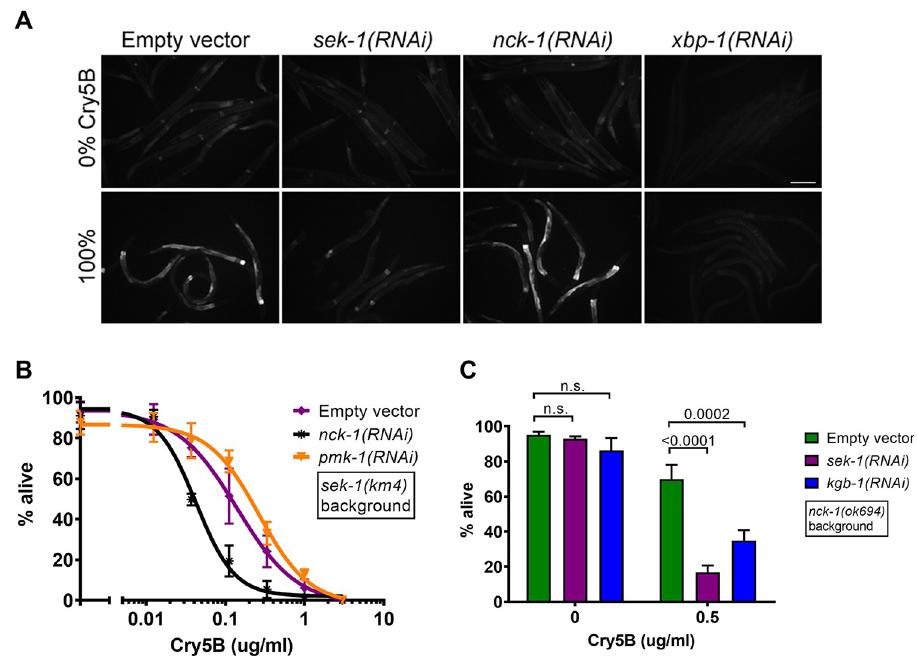
Fig 2. nck-1 works independently of MAPK signaling. (A) hsp-4 :: gfp C . elegans were grown to the L4 stage on the indicated RNAi bacteria and transferred to E . coli plates expressing empty vector or Cry5B for 8 hours, then subjected to fluorescence microscopy. Scale bar = 0.1mm. (B) sek-1(km4) p38 MAPKK(-) mutant C . elegans were grown on the indicated RNAi bacteria to the L4 stage and then transferred to liquid culture with varying amounts of purified Cry5B and incubated for 6 days before being scored for survival. pmk-1 is p38 MAPK. (C) The reverse experiment to the one in (B), with nck-1(ok694) mutant animals and RNAi of MAPK pathway genes at a single concentration of Cry5B. For (B) and (C), each data point is the average of three independent experiments with three wells/experiment (n = 20–33